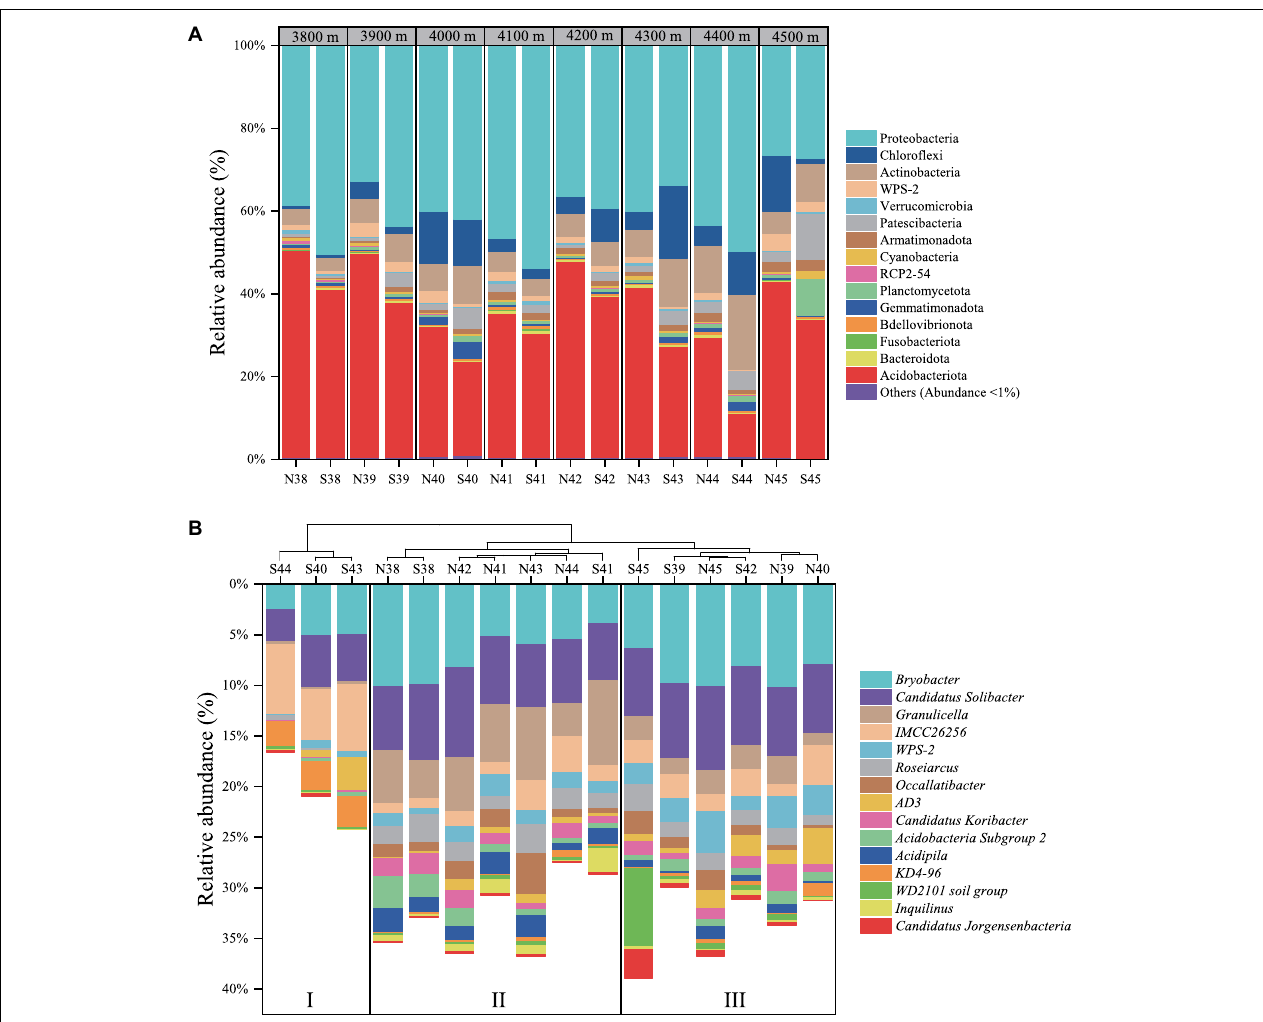
FIGURE 1 | Community structure of soil bacteria at Mt. Shergyla at the phylum (A) and genus (B) levels. In the identities of soil samples, “N” and “S” represent the soils collected from the north and south slopes, respectively, and the number indicates the altitude of sampling sites.